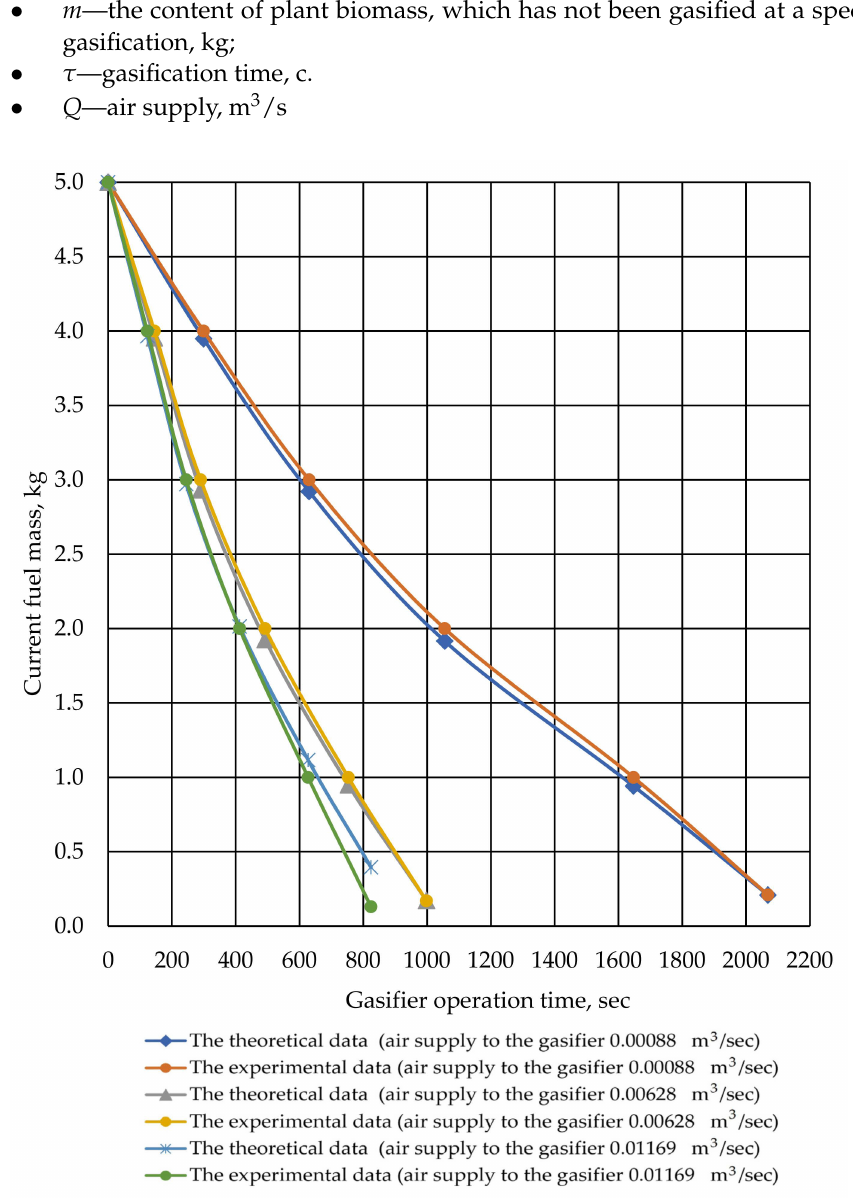
Figure 4. Comparison of the experimental and theoretical indicators of a change of fuel mass when using wood in